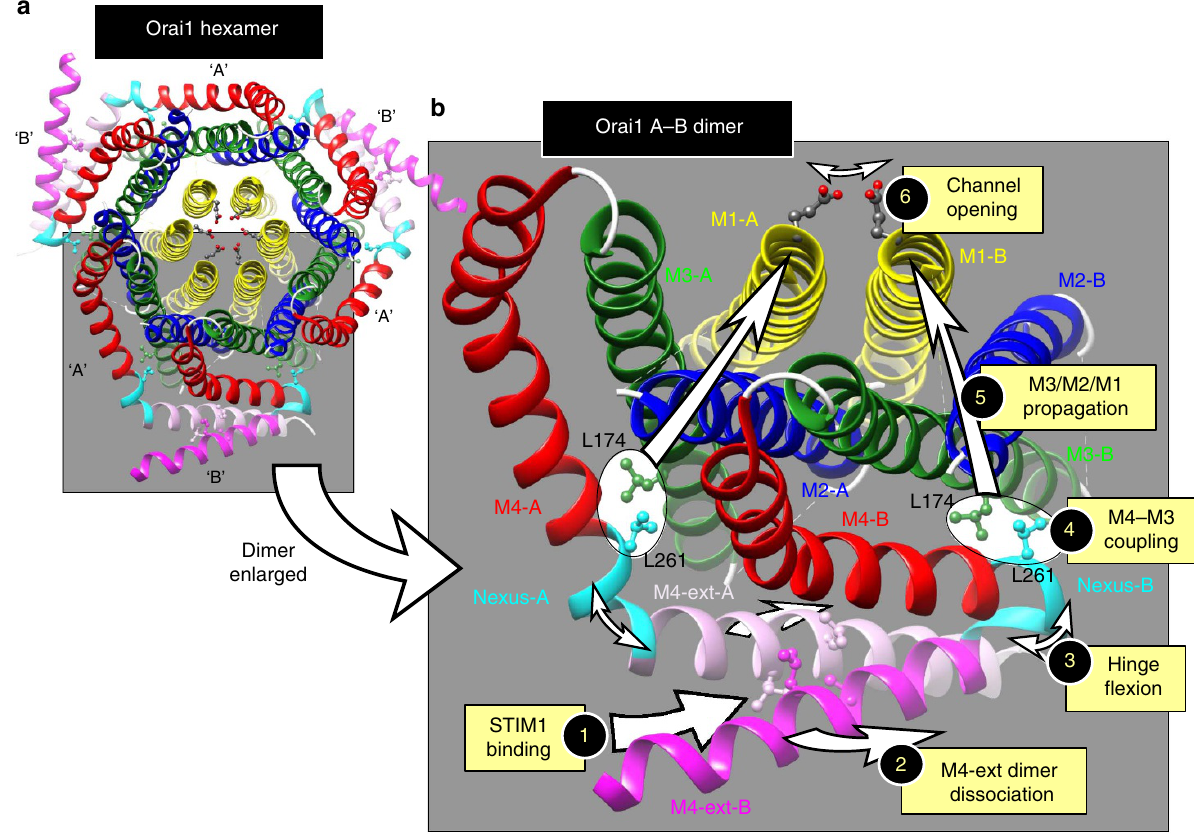
Figure 8 | Postulated gating mechanism for Orai1 by STIM1. ( a ) The hexameric Drosophila Orai crystal structure 18 , comprising three pairs of Orai dimers. As described in Supplementary Fig. 1, dimers are formed from ‘A’ and ‘B’ subunits with identical sequence, differing only in the degree of bending of the nexus hinge. ‘A’ subunits are only slightly bent and ‘B’ subunits are bent almost 180 (cid:2) so that the two M4-ext sequences in the dimer pair lie antiparallel to each other, bound by hydrophobic interactions between the hOrai1 equivalent residues, L273 and L276. ( b ) Enlarged view of the Orai1 dimer showing the postulated gating mechanism activated by STIM1. STIM1 binding to the M4-ext pair (1) requires that the two M4-ext helices are in the conjoined antiparallel configuration, but they must be capable of undergoing dissociation for STIM1 to successfully bind to Orai1 (ref. 20). Likely, STIM1 binding induces some degree of dissociation between the two M4-ext helices (2). Such dissociation is permitted by the ability of the nexus ‘hinge’ (263–265, SHK) to undergo flexion, and recent evidence reveals flexion of the hinge is required for STIM1-induced gating of the Orai1 channel 13,20,37 . Flexion of the hinge (3) likely induces conformational change in the adjoining ‘hinge-plate’ residues (261–262; LV) of the M4 helix. The M3 helix L261 residue undergoes close hydrophobic interaction with the M3 helix L174 residue (4), hence displacement of the M4 residue induces a conformational change in M3. This conformational change is propagated through the tightly packed M3, M2 and M1 helices (5) to induce conformational alteration of the external entrance to the pore (6), as recently shown 12 FRET measurements . FRET was examined using a modified protocol 19 . FRET signals occurring between STIM1-YFP stably expressed in cells and CFP-Orai1- WT or CFP-Orai1 mutants transiently expressed were measured using a Leica DMI 6000B inverted automated fluorescence microscope that was equipped with CFP (438Ex/483Em), YFP (500Ex/542Em) and FRET (438Ex/542Em) filter cubes. During experiments, images were captured at 20s intervals to avoid photobleaching. Three sets of images (CFP, YFP and FRET) were collected for each time point (room temperature) using a (cid:3) 40 oil objective (numerical aperture 1.35; Leica). Images were processed using the Slidebook 6.0 software (Intelligent Imaging Innovations), images captured at intervals of 20s. In each case, exposure times were 1,000, 250 and 1,000ms for the CFP, YFP and FRET channels, respectively; the decreased channel exposure time for YFP compensates for the greater YFP fluorescence intensity as compared with CFP. Calculation of three-channel corrected FRET used the formula F C ¼ I DA (cid:2) Fd = Dd (cid:3) I DD (cid:2) Fa = Da (cid:3) I AA ð 1 Þ in which I DD , I AA and I DA are the intensities of background-subtracted CFP, YFP and FRET images, respectively, F C is the corrected energy transfer, Fd/Dd is the measured bleed-through of CFP across the FRET filter (0.457) and Fa/Da is the measured bleed-through of YFP across the FRET filter (0.19). To analyse three- cube FRET images, we utilized the E-FRET method, which was described by Zal and Gascoigne 35 using the formula: